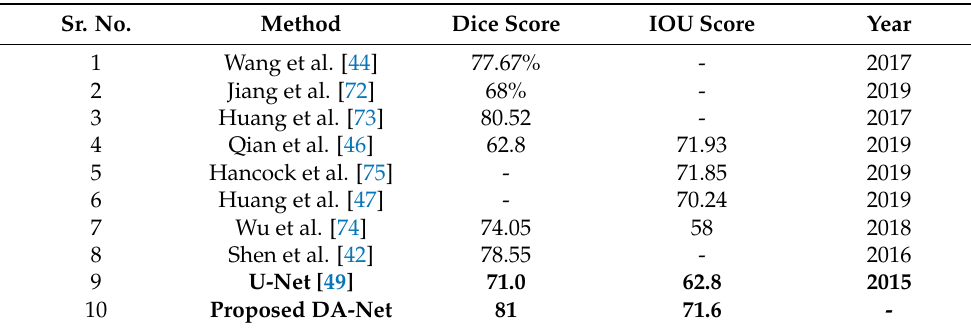
Table 2. Comparative analysis with state-of-the-art work. Sr.